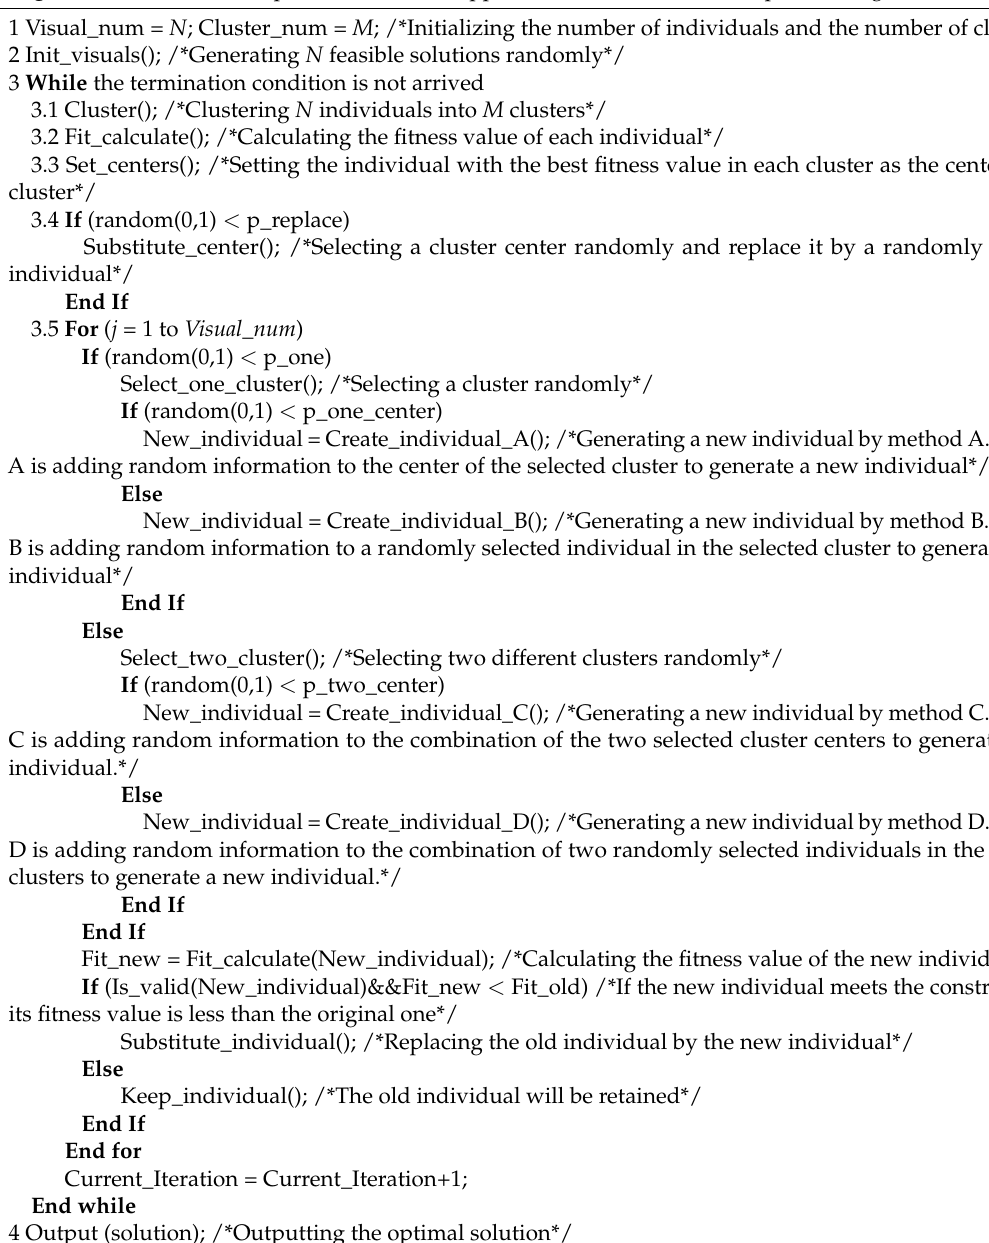
Algorithm 1. Brainstorm optimization (BSO) applied to hardware/software